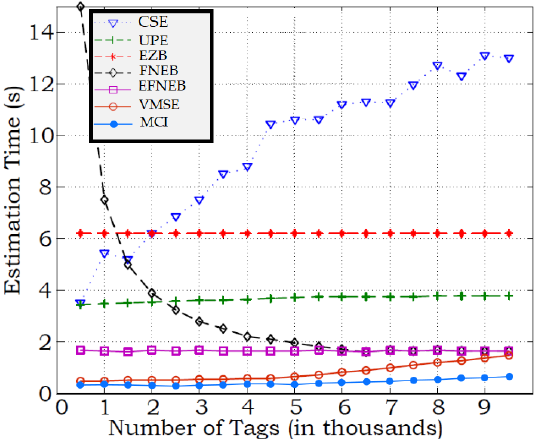
Figure 13. Comparison of average counting/estimation time of tags under different protocols.